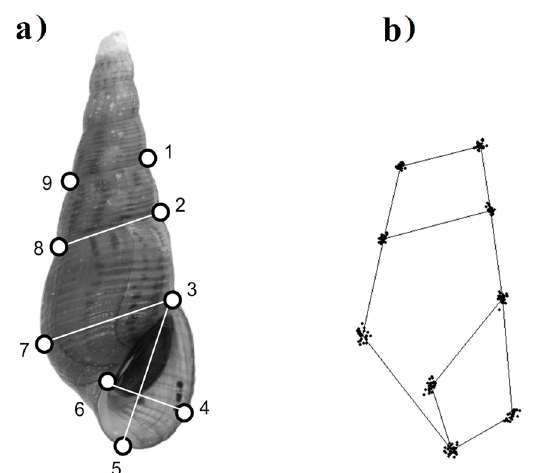
Figure 2. Geometric morphometric analysis of Melanoides tuberculata snails from La Carrindanga Road channel (Bahía Blanca city): a) landmarks defined on the shell (shell length of the specimen in the photograph is 21 mm) b) consensus shape of the set of 29